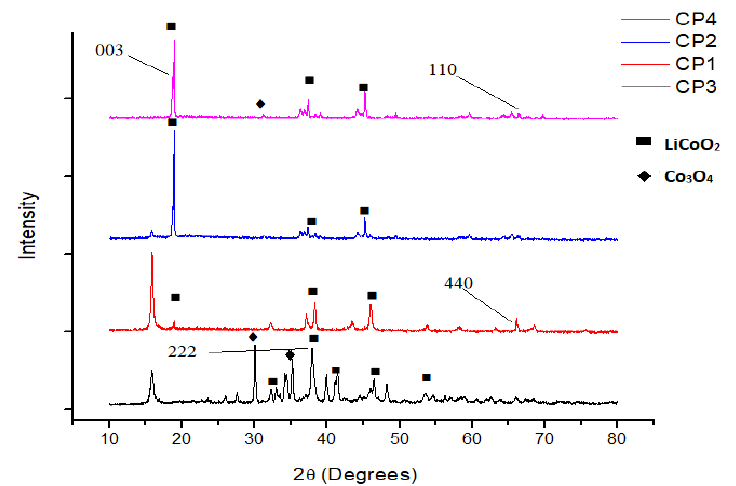
Figure 3. X-ray diffractogram of CP4 (waste material after calcination at 600 °C), CP2 (recovered material, calcined at 800 °C); CP1 (Recovered material, calcined at 700 °C), and recovered material, (calcined at 600 °C).